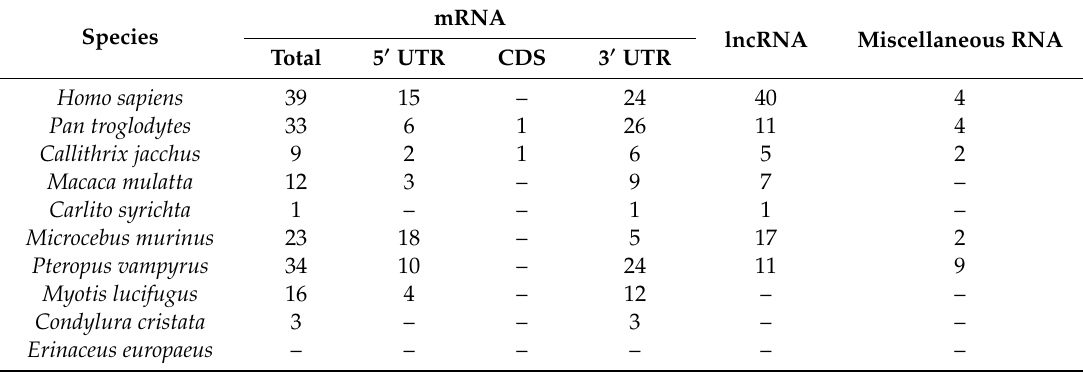
Figure 3. Genomic distribution of MER6 elements in assayed genomes. Number of insertions (blue bars) and percentage of insertions (green line) occurring within genic regions (annotated genes ± 5000 bp flanking regions). Table 2. Occurrence of BLAST significant alignments of MER6 and MER6A in transcriptomes.